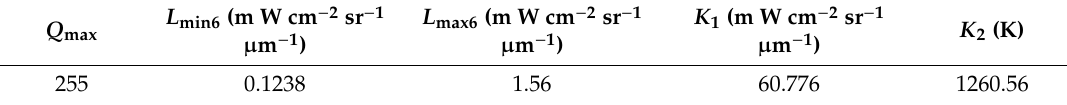
Table 2. Parameters for computing at-sensor brightness temperatures from Landsat 5 TM band 6 data.